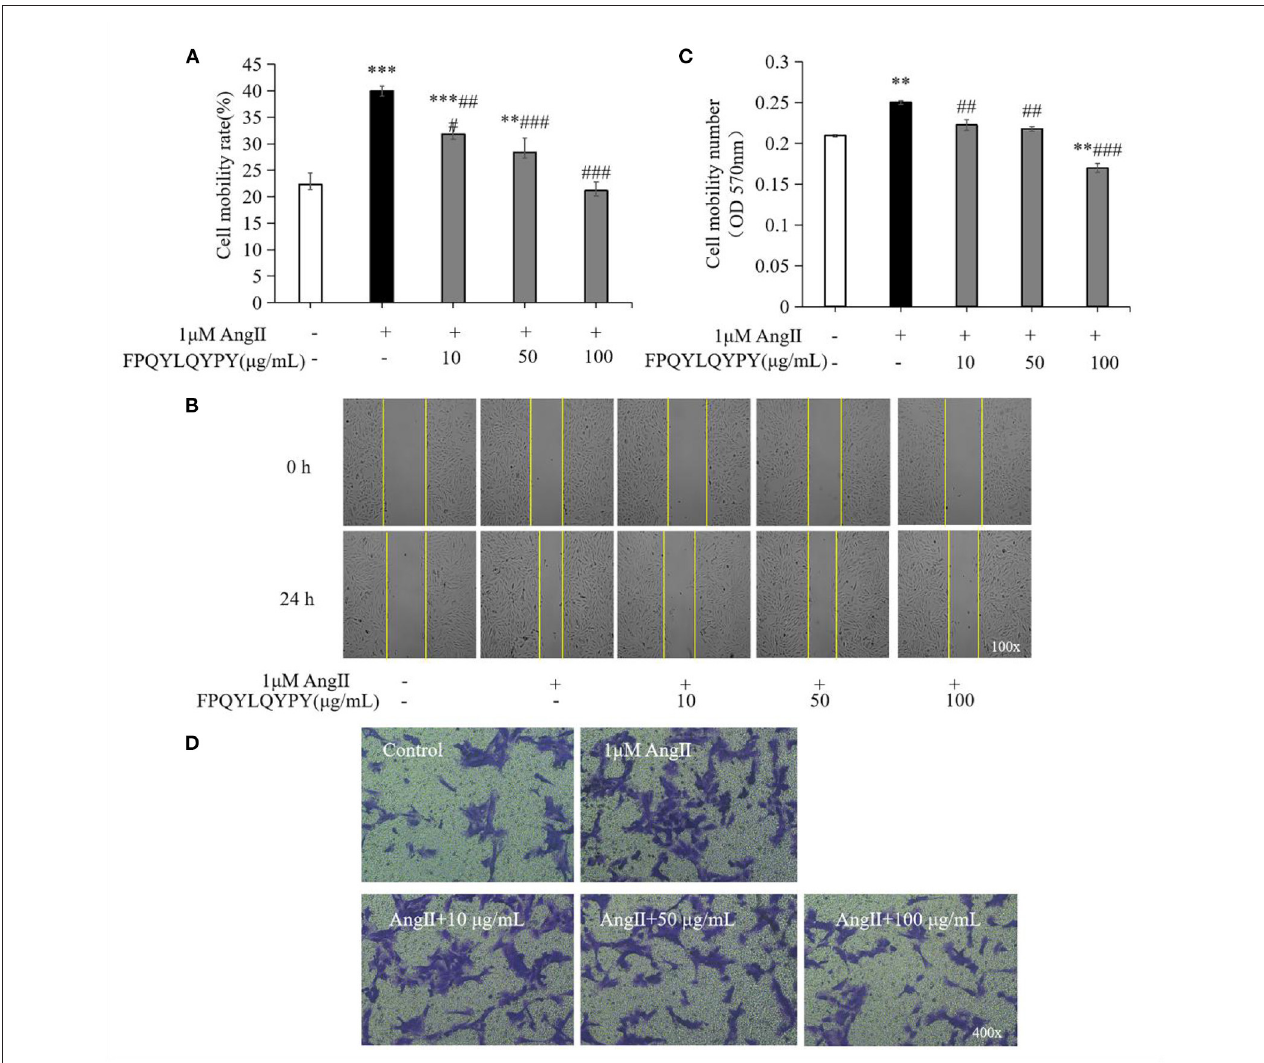
FIGURE 5 | FPQYLQYPY inhibited migration of Ang II-stimulated VSMCs. (A,B) Cell migration was evaluated by wound healing assay, and the distance of the wound healing area was measured by ImageJ software. (C,D) Cell migration was evaluated by Transwell experiments. All the data are represented as the mean ± SD. ** P < 0.01 and *** P < 0.001, respectively, as compared to the control group. ## P < 0.01 and ### P < 0.001, respectively, as compared to the Ang II-treated